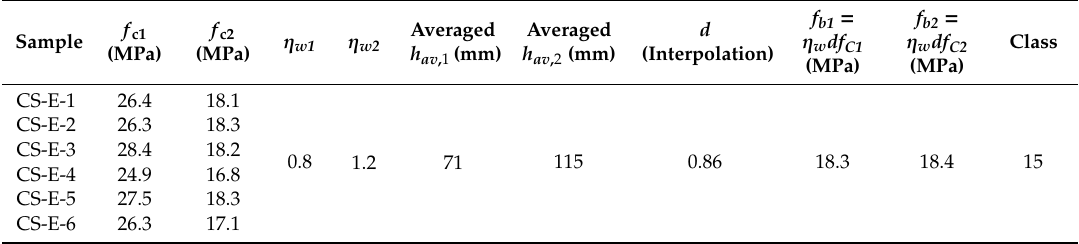
Table 4. The results obtained from the compressive strength tests carried out on the CS-E specimens used to convert to the strength class of the product.